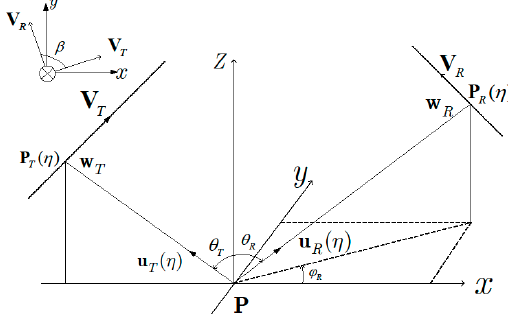
Figure 1. Imaging geometry of bistatic SAR.